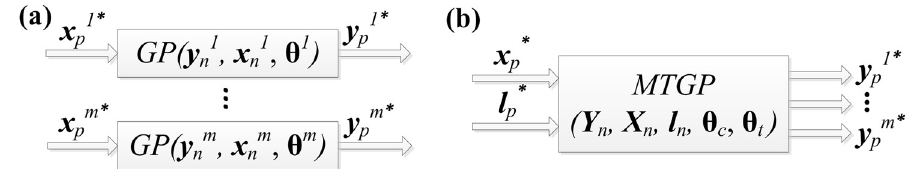
Figure 2. Box diagram of ( a ) multiple STGPs and ( b ) MTGP for multi-task modeling.